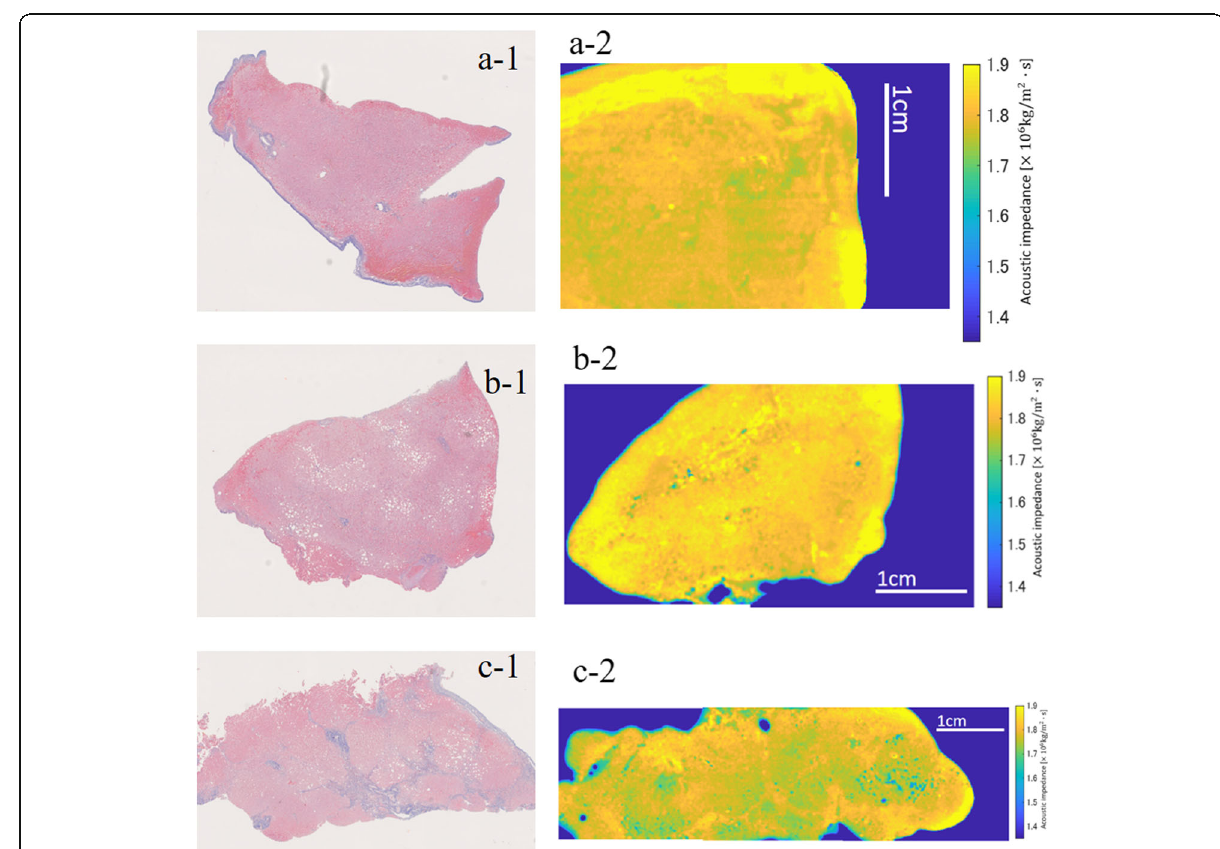
Fig. 3 Images of human liver sample. a Control. ( a-1 ) Masson trichrome stain: no fibrosis and no steatosis. ( a-2 ) Acoustic impedance image: light yellow area and dark yellow area with a few green part; median acoustic impedance was 1.81 × 10 6 kg/m 2 /s. b Simple steatosis. ( b-1 ) Masson trichrome stain: no fibrosis with 40% fat deposition. ( b-2 ) Acoustic impedance image: light yellow area and dark yellow area with a few green part; median acoustic impedance was 1.78 × 10 6 kg/m 2 /s. c Nonalcoholic steatohepatitis. ( c-1 ) Masson trichrome stain: advanced fibrosis (F3-4) with 20% fat deposition. ( c-2 ) Acoustic impedance image: dark yellow area and green area are dominant; median acoustic impedance was 1.77 × 10 6 kg/m 2